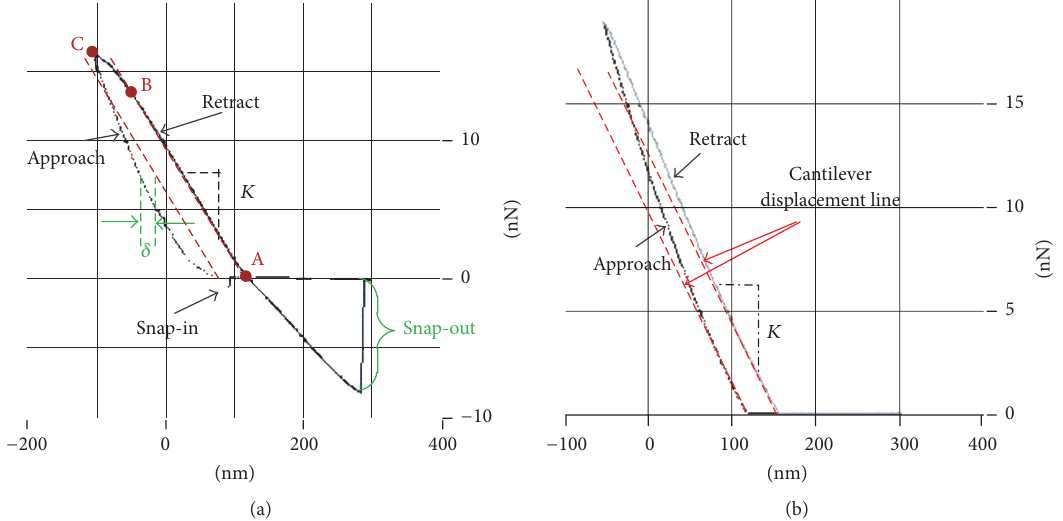
Figure 3: Force-piezo displacement for (a) SPEEK and (b) PEEK via AFM.